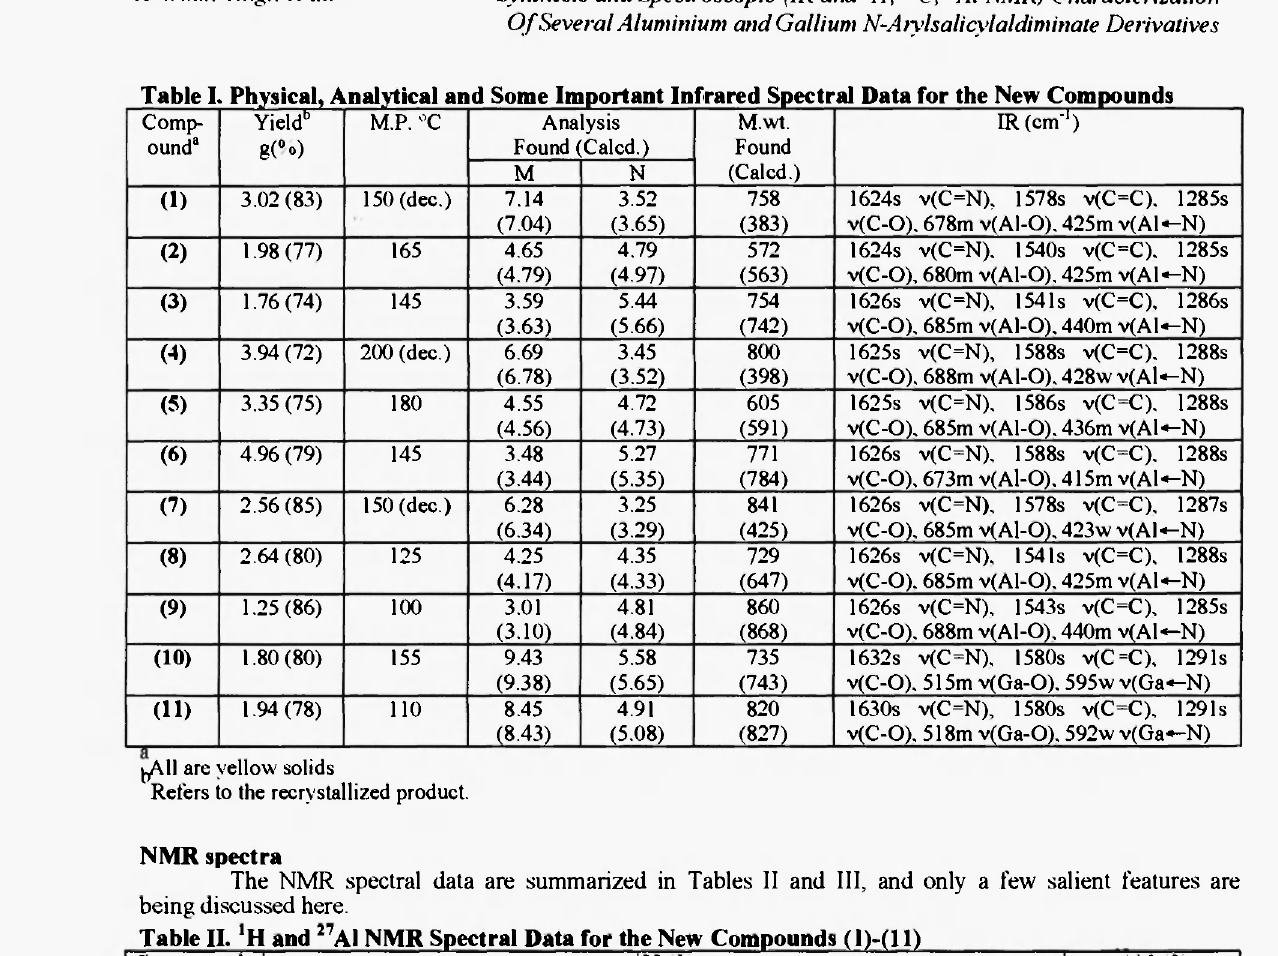
Table II. 'H and 27 AI NMR Spectral Data for the New Compounds (l)-(l 1)